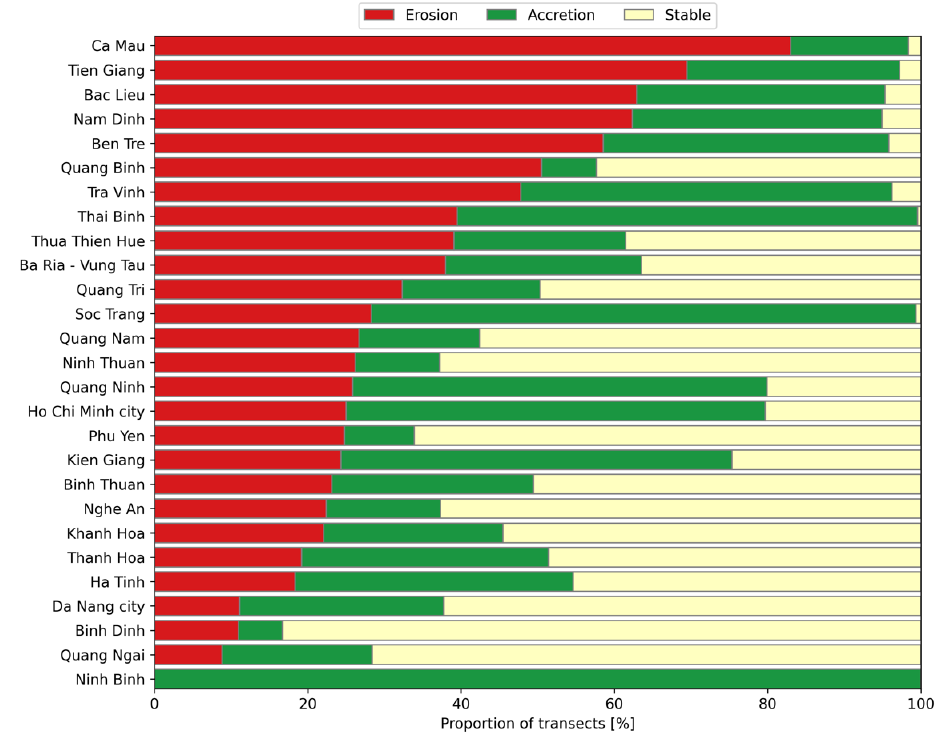
Figure 8. Coastline change per province, showing the proportion of transects with erosion, accretion and stable conditions from 1986 to 2021.